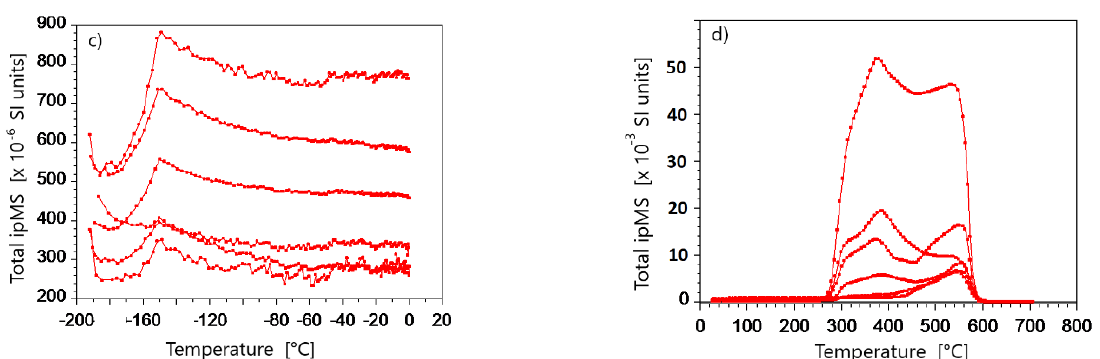
Figure 10. Variation in opMS and ipMS in a few specimens of graphite-bearing rock from M ě stský vrch locality according to the intensity of magnetizing field ( a , b ) and variation of ipMS with tem- perature ( c , d ). Adapted from [26].